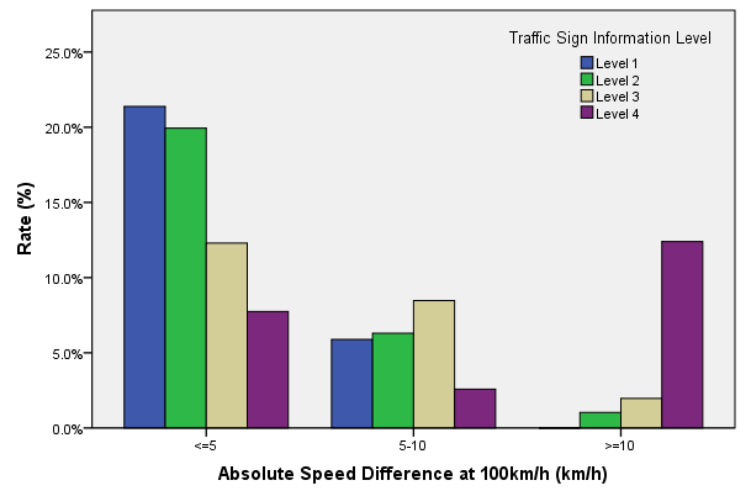
Figure 10. Proportion of the difference between driving speed and target speed ( ∆ V) in different sections.